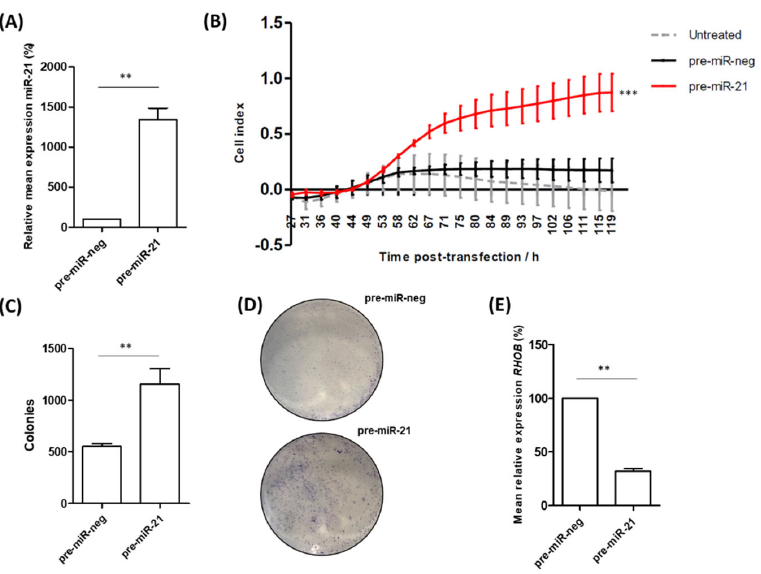
Figure 4. miR-21 over-expression increases migration and colony-forming ability of RWPE-1 cells. ( A ) Confirmed over-expression of miR-21 in RWPE-1 cells resulted in ( B ) significantly increased capability for migration of the pre-miR-21 transfected cells, relative to untreated and the scrambled negative control (pre-miR-neg). (One-way ANOVA, *** p < 0.001.) Mean ± SEM of three biological replicates is shown. ( C ) Cells transfected with miR-21 have significantly higher colony-forming ability compared to cells transfected with pre-miR-neg as shown by quantified colony forming assays ( n = 3) and ( D ) representative images of crystal violet colony staining. ( E ) Confirmation that RHOB mRNA levels are reduced in RWPE ‐ 1 cells following overexpression of pre ‐ miR ‐ 21. (All bar charts; paired t ‐ test, ** p < 0.01.)